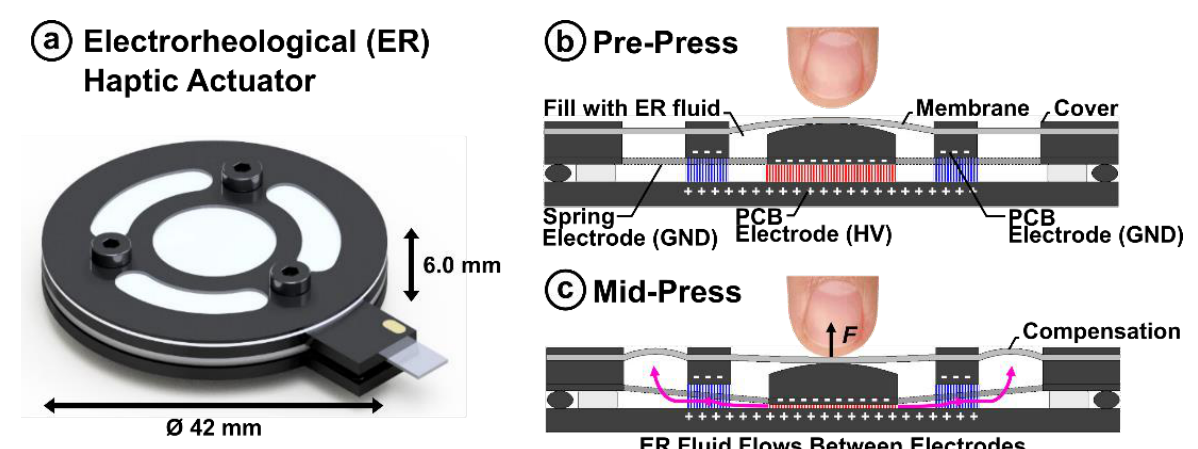
Figure 1. ( a ) Form factor of the ER fluid-based haptic actuator. Cross-section view of the working principle of the cylindrical haptic actuator ( b ) pre-press and ( c ) mid-press. Reproduced with permission [56]. Copyright 2020, IOP.